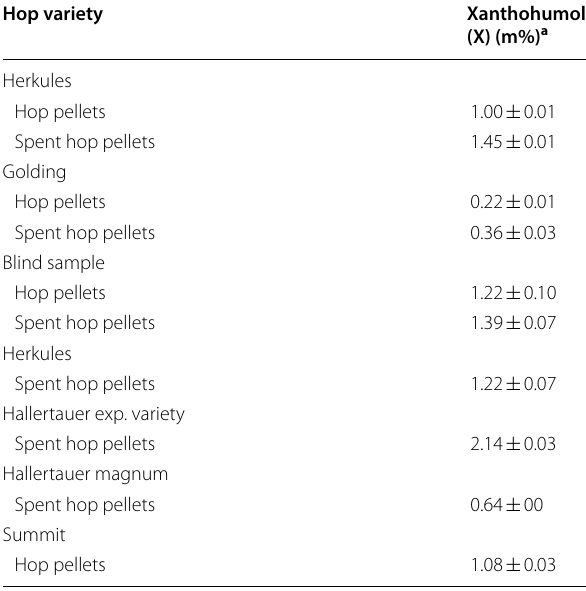
a Concentrations are expressed as mass percentage on the samples as such (without consideration of dry weights)